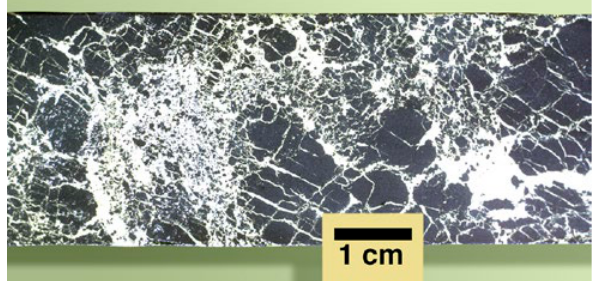
Figure 38. Syneresis of the gelatinous lepidocrocite precursor in the massive magnetite ore envelope at Warrego Mine, Tennant Creek, has developed a strong pattern of shrinkage cracks that have been filled with quartz. There are several episodes of mobility in the sili- ceous matrix that has suspended the heavy magnetite fragments by its rapid rheopectic re-setting.